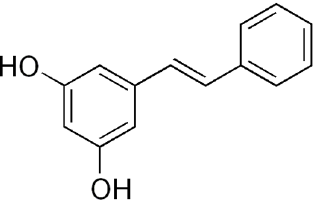
Figure 5. The chemical structure of pinosylvin, a stilbene-based compound found in plants, berries, and nuts [58].